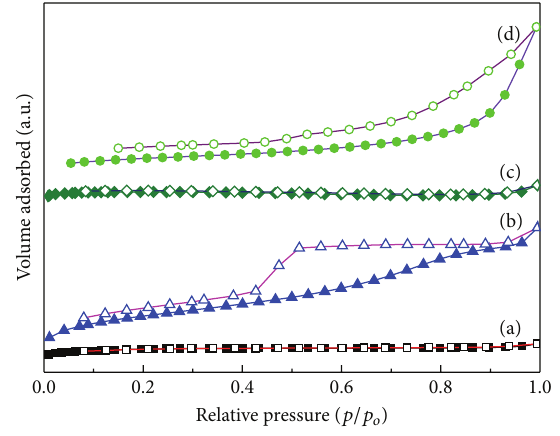
Figure 9: N 2 adsorption isotherms of the iron nitride samples. (a) FN-1, (b) FN-2, (c) FN-3, and (d)